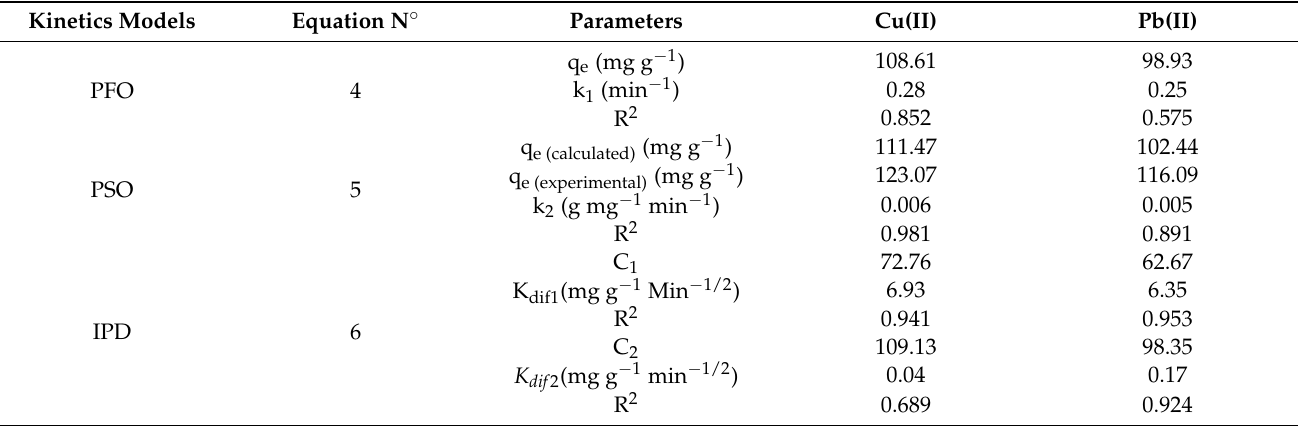
Table 1. Kinetics models parameters for the adsorption of Pb(II) and Cu(II) ions by MgO nanorods.